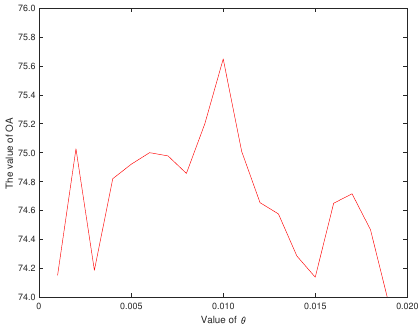
Figure 14. The OA values obtained by the proposed algorithm with different θ values.